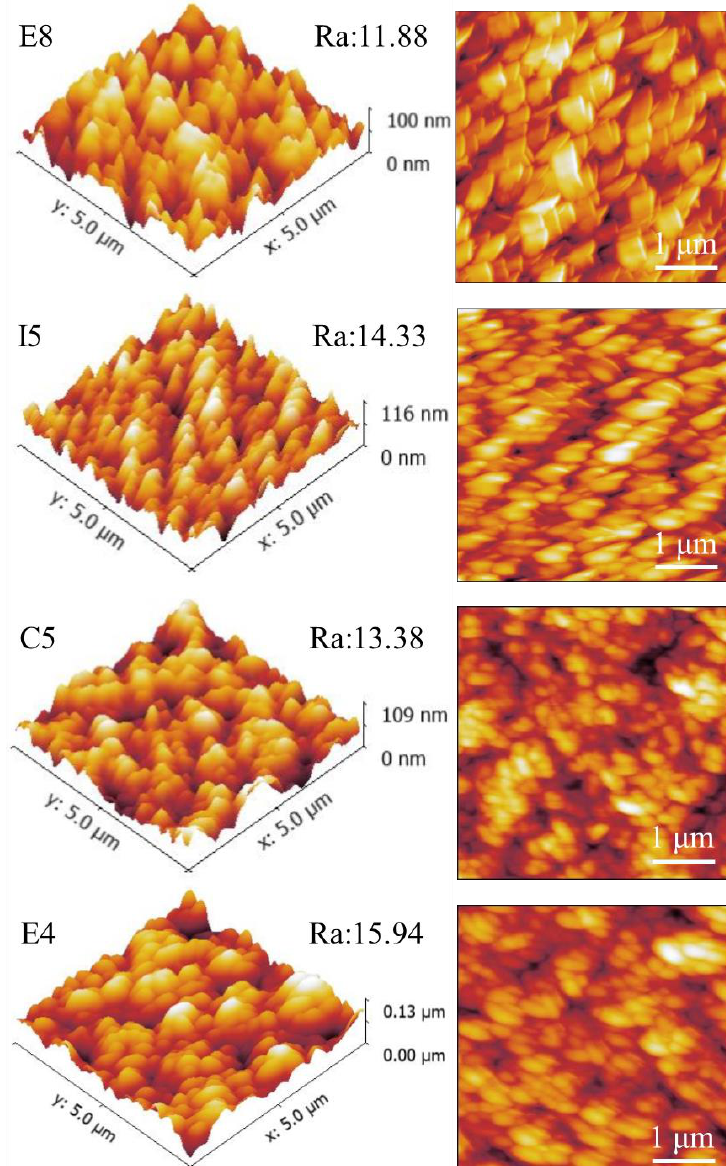
Figure 8. AFM surface roughness of ZrMoTaW RMPEA thin films: E8 Zr 12 Mo 23 Ta 25 W 40 ; I5 Zr 19 Mo 41 Ta 20 W 20 ; C5 Zr 18 Mo 18 Ta 36 W 28 ; E4 Zr 29 Mo 27 Ta 26 W 18 . Zr 19 Mo 41 Ta 20 W 20 ; C5 Zr 18 Mo 18 Ta 36 W 28 ; E4 Zr 29 Mo 27 Ta 26 W 18